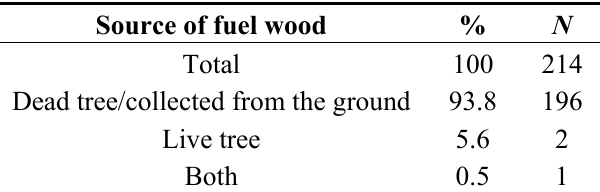
Table 2. Fuel wood